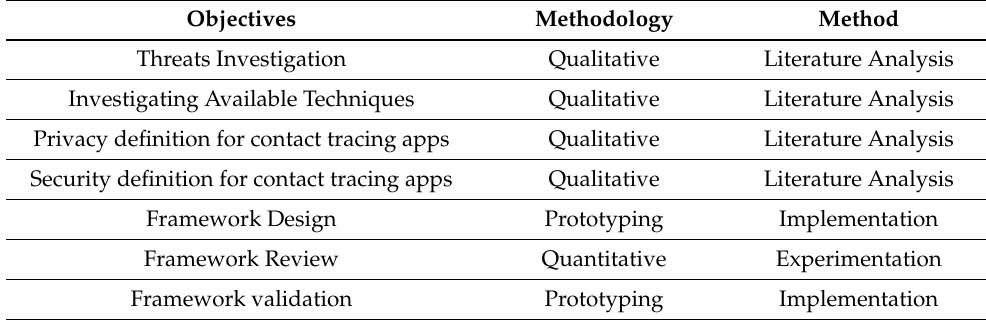
Table 1. The used research